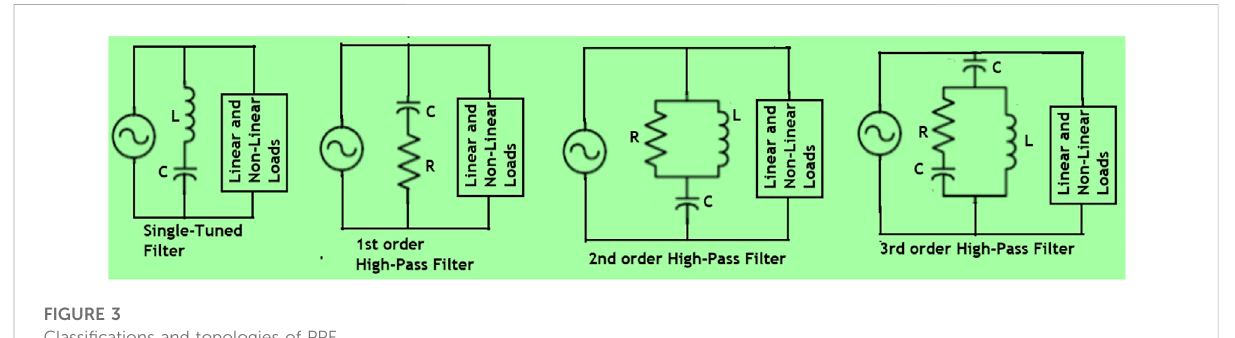
FIGURE 3 Classi fi cations and topologies of PPF.